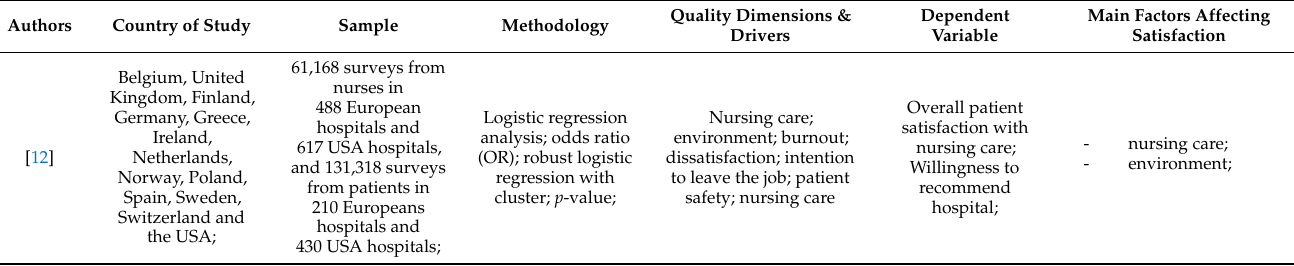
Table 1. Review of collected